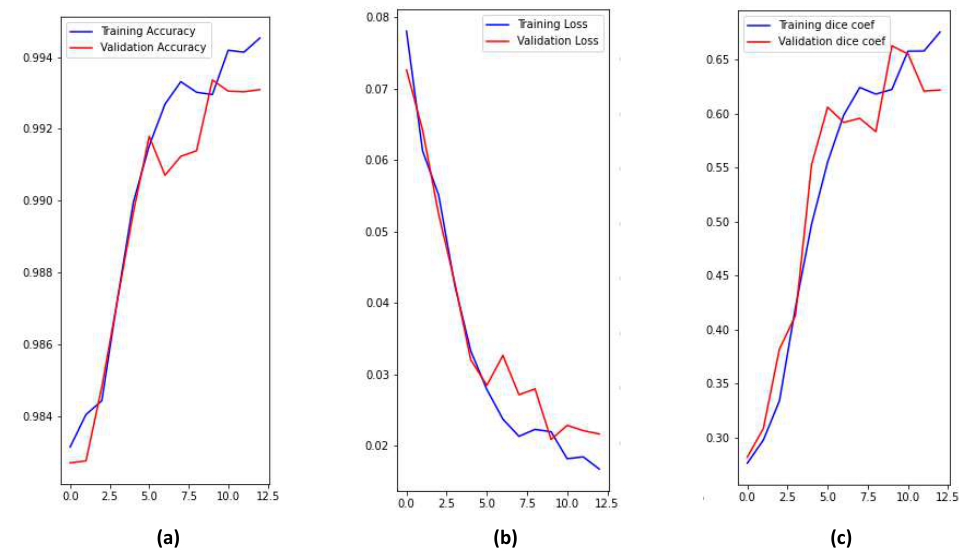
Figure 9. Training and validation performance parameters; ( a ) Accuracy, ( b ) Loss, ( c ) Dice